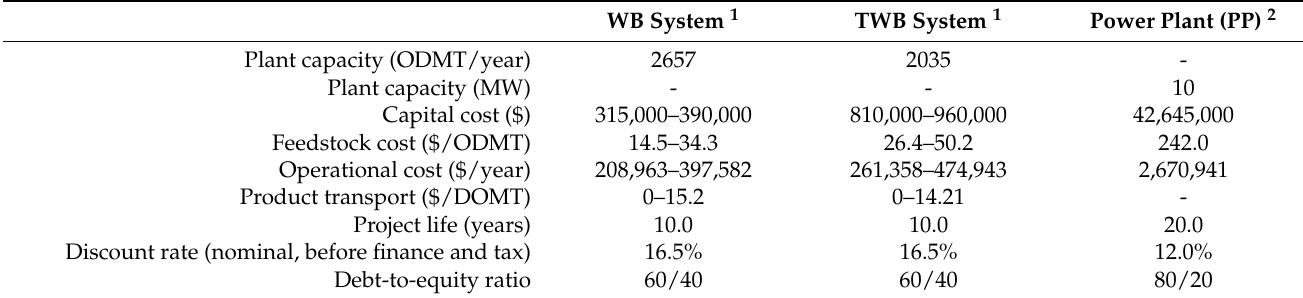
Table 4. Capital and operating costs in WB, TWB, and electricity production